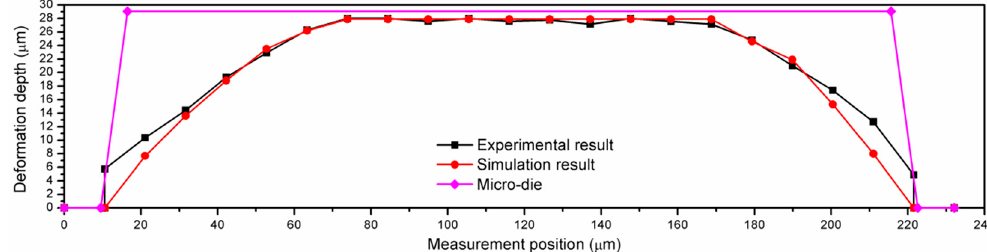
Figure 10. Cross-section curves of one microchannel under the laser energy of 1800 mJ in the experiments and numerical simulation.